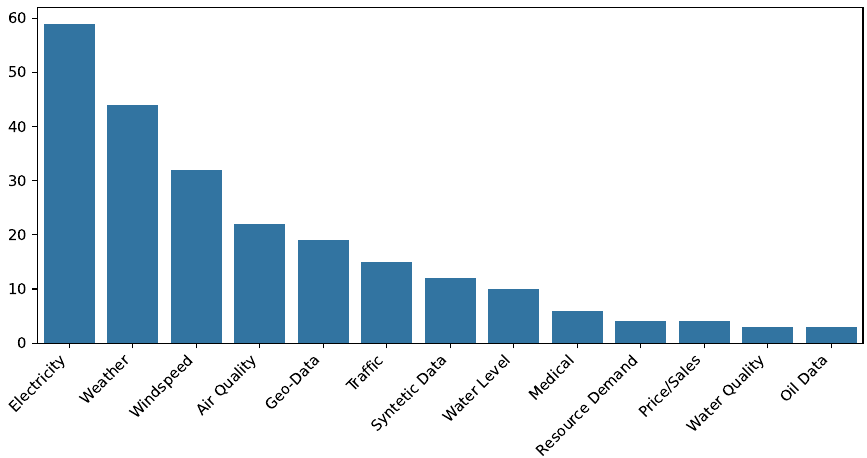
Figure 3. Domain distribution of the datasets which were identified while screening the “Web of Science” publication corpus.